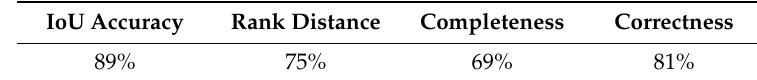
Table 9. Accuracy metrics calculated for the Taklimakan Desert results. Figure 19. Sentinel–2 image of the same area as in Figure 17. The image was acquired on 31 July 2019 (roughly in the middle of the Sentinel–1 time series). It is displayed in true colour, bands 4,3,2 as red, green, and blue, respectively. Contains modified Copernicus Sentinel data 2020.